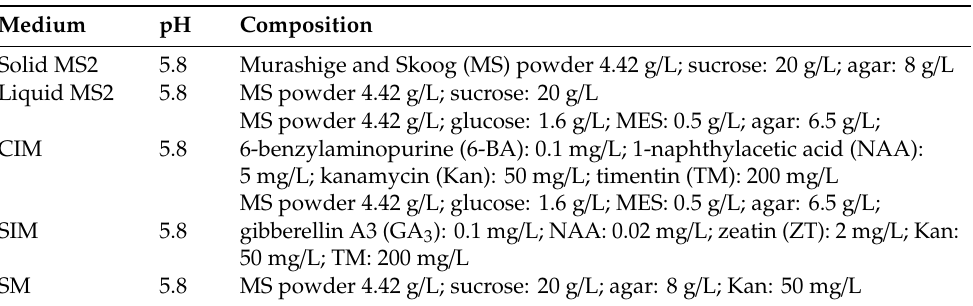
Table 2. Media used for potato